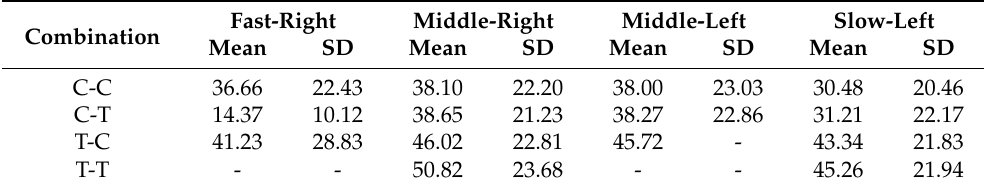
Table A9. The mean and standard deviation of TTC of m and n2. Fast-Right Combination